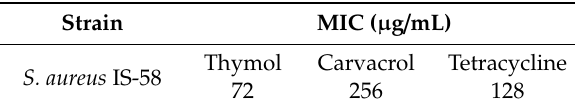
Table 1. Minimum inhibitory concentrations (MIC, µ g / mL) of thymol, carvacrol and tetracycline against the S. aureus IS-58